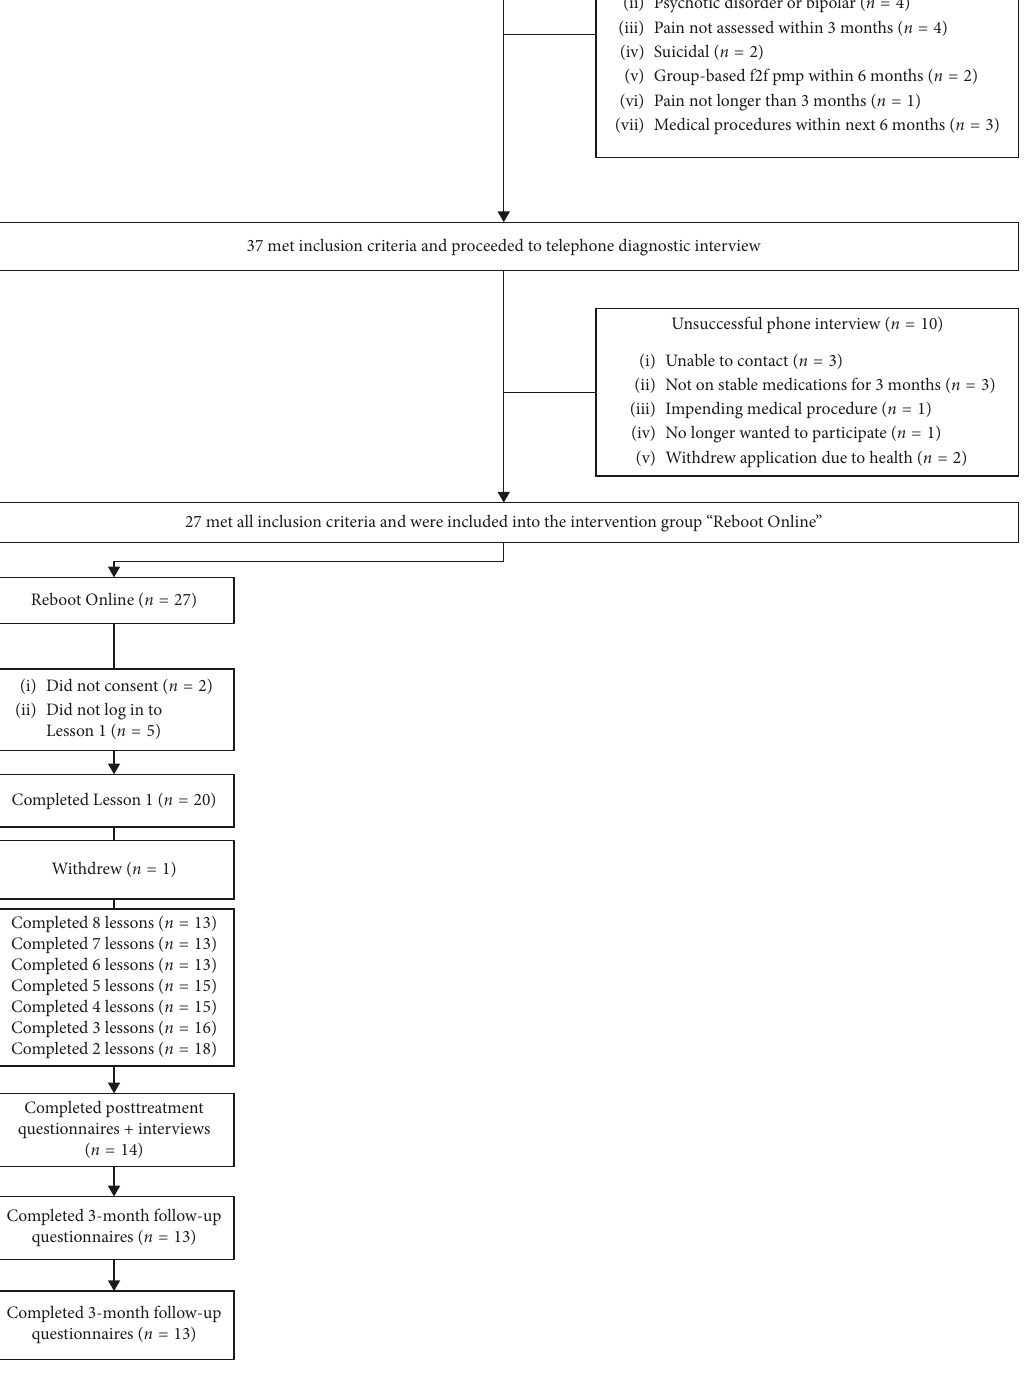
Figure 1: Participant flow for recruitment and